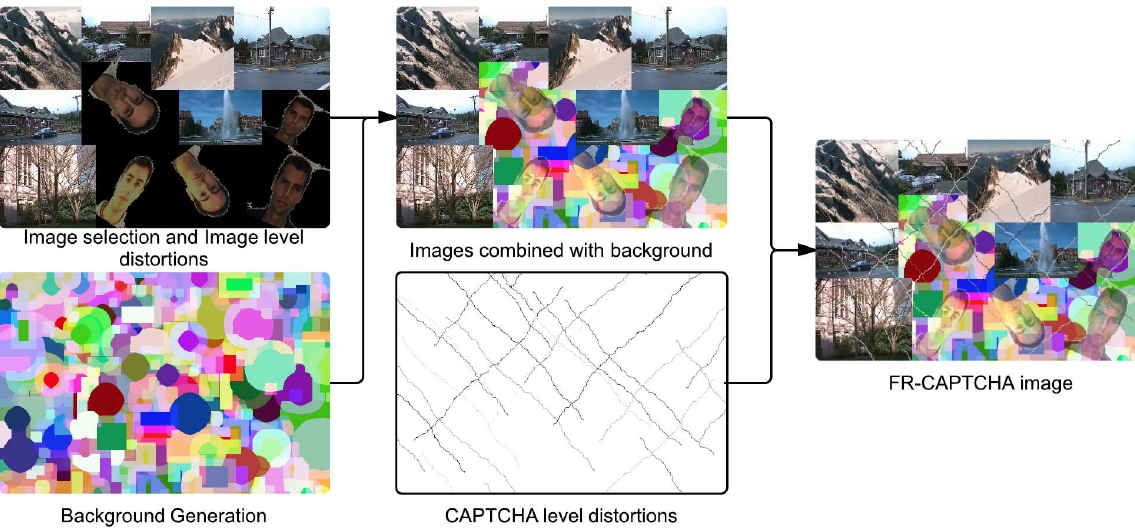
Figure 2. The FR-CAPTCHA generation process. An image of the same size is created using a randomly selected set of human faces and other non-face images after applying different amounts of rotation to each image. A background of the same size is generated using various colored shapes. A new image is generated by blending this image with the background. This combined image is then further processed to add noise, illumination variance, and false edges. The resulting image is a